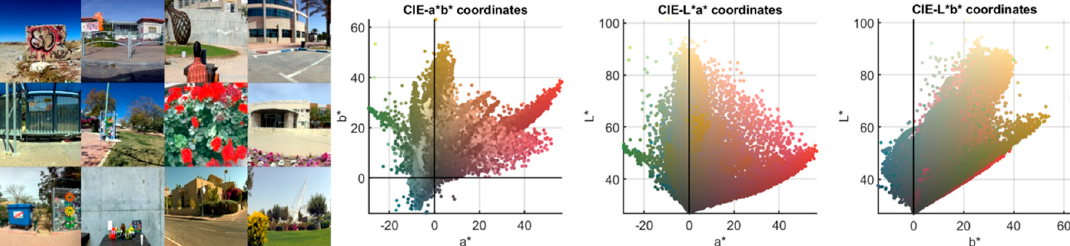
Figure 2. sRGB rendering (i.e. into the standard RGB space [33]) of the 12 scenes present in D2 (selected from a hyperspectral image database [30]) under illuminant D65, and their L*a*b* projections.